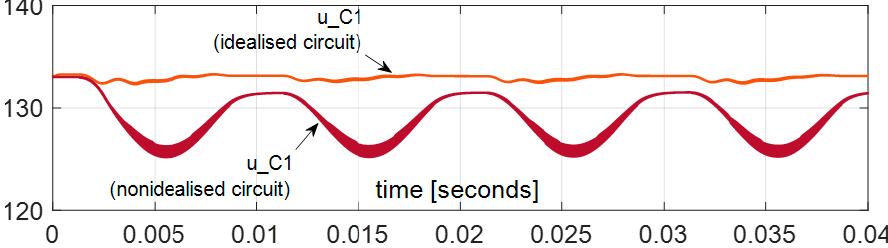
Figure 11. Steady state waveforms of voltage on the C 1 DC-link capacitor in idealized case ( R dson ≈ 0 and V F ≈ 0), and nonidealized case ( ∑ R dson ≈ 100 m Ω and V F ≈ 1.5 V for each diode).